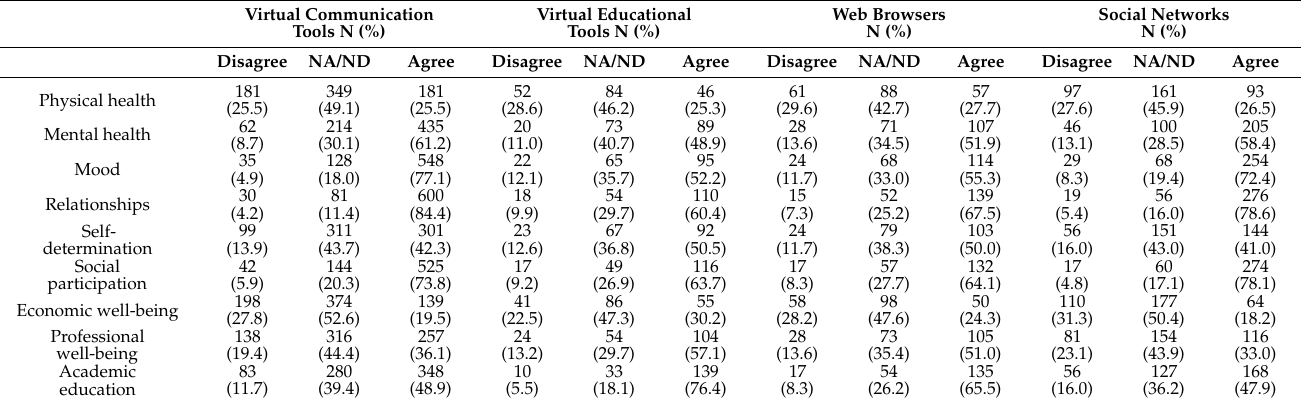
Table 4. Benefits reported by participants who performed intergenerational virtual